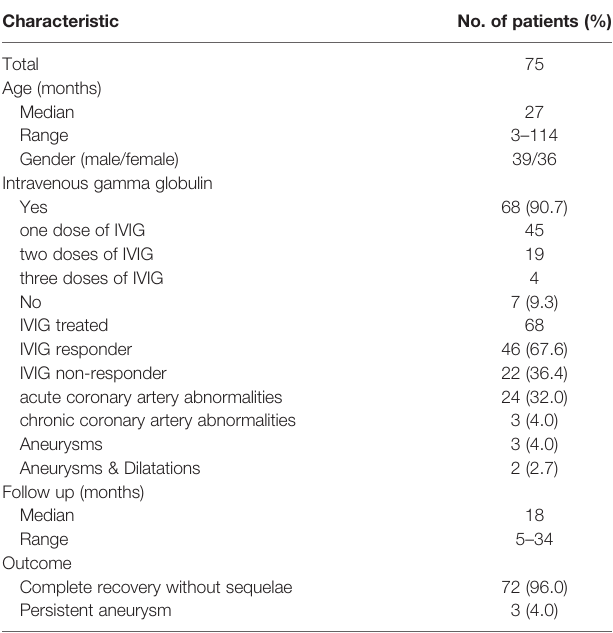
TABLE 1 | Clinical characteristics of patients with Kawasaki